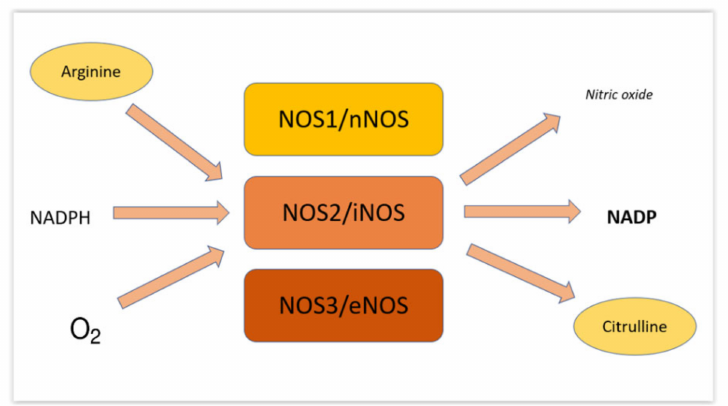
Figure 3. Biological pathways of nitric oxide generation in vivo in the body. Image created by authors.